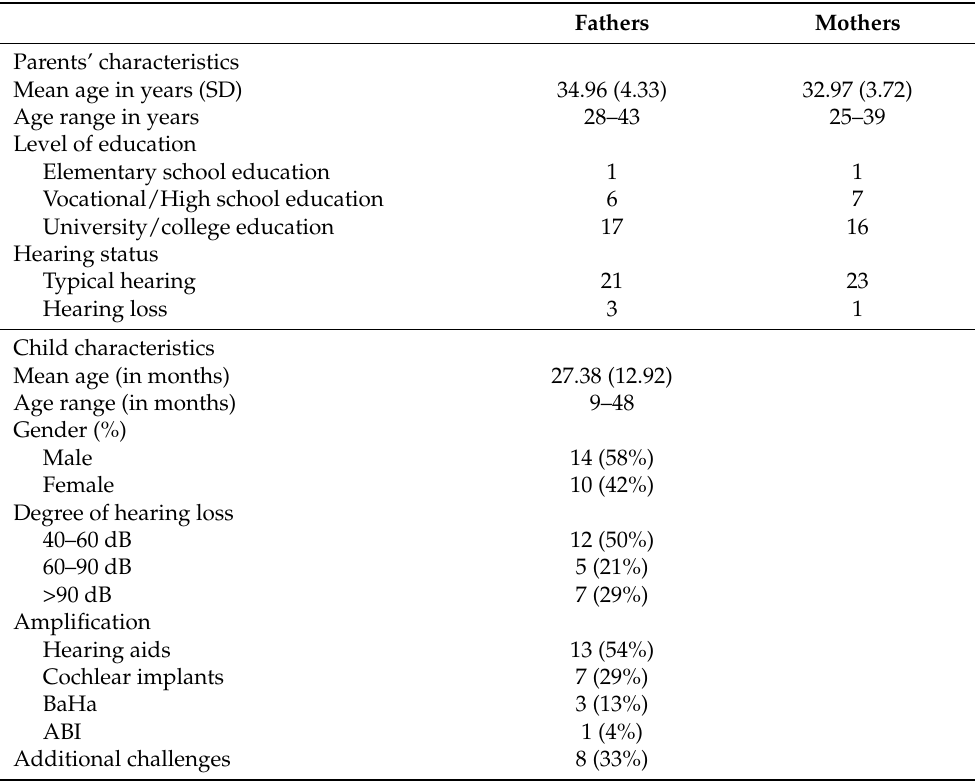
Table 1. Demographic characteristics of participants in the present